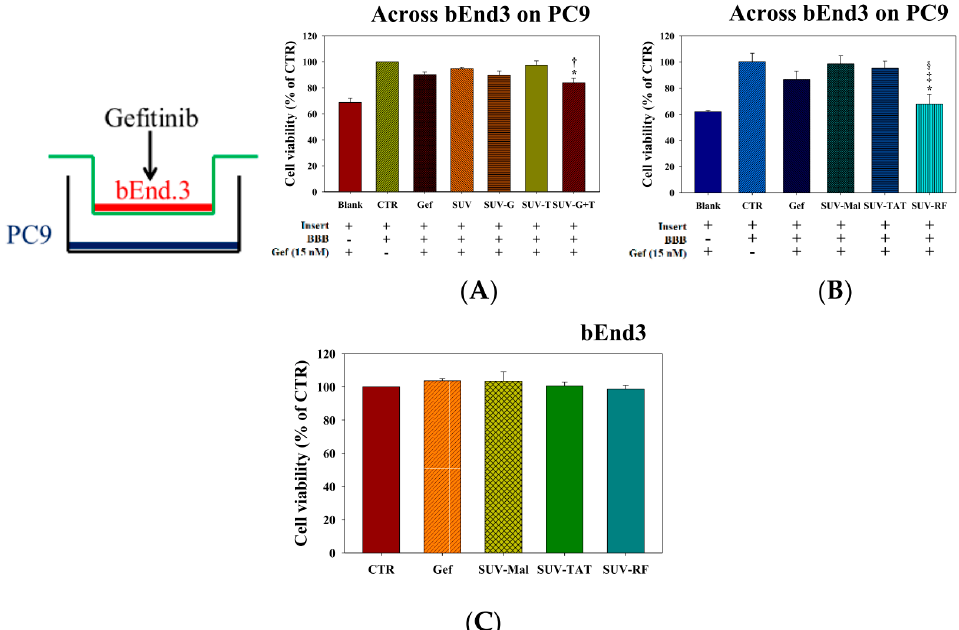
Figure 5. Cytotoxic effects of different liposomal gefitinib formulations across the BBB on PC9: ( A ) PC9 cells were treated with free gefitinib, SUV, SUV-G, SUV-T, and SUV-G+T with or without the BBB for 48 h; ( B ) PC9 were treated with free gefitinib, SUV-Mal, SUV-RF, and SUV-TAT with or without the BBB for 48 h; and ( C ) bEnd.3 cells were treated with free gefitinib, SUV-Mal, SUV-RF, and SUV-TAT for 48 h. Cell viability was determined using the SRB assay. Values are the mean ± SEM. ( n = 3). * p < 0.05 compare to the Gef, † p < 0.05 compare to the SUV, ‡ p < 0.05 compare to the SUV-Mal, § p <0.05 compare to the SUV-TAT by Student ′ s t -test analysis.